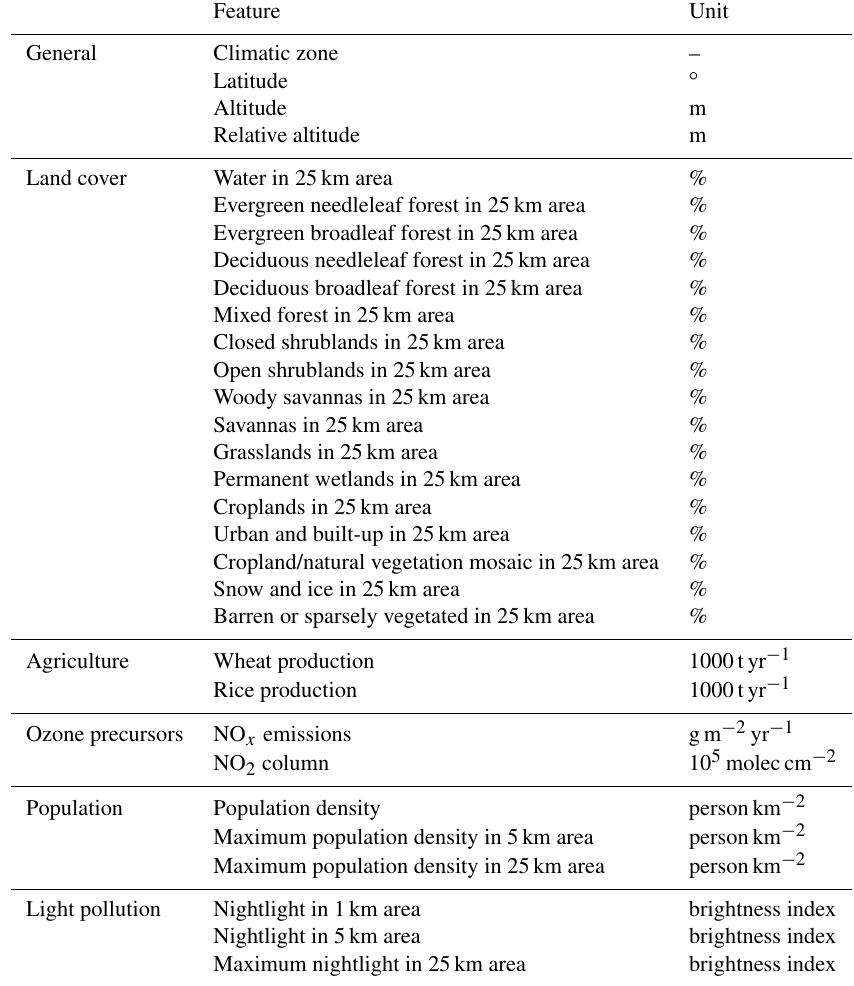
Table 1. Features selected from the AQ-Bench